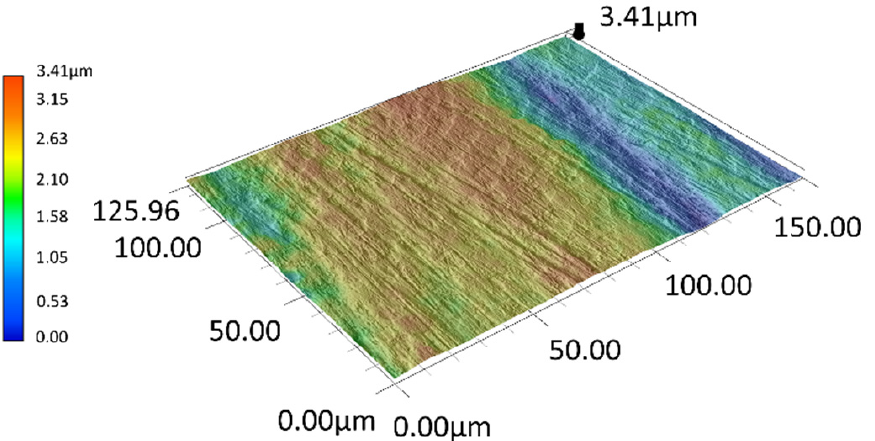
Figure 13. A surface profile of PMFe60P padding weld worn in the light soil. Optical light microscopy.